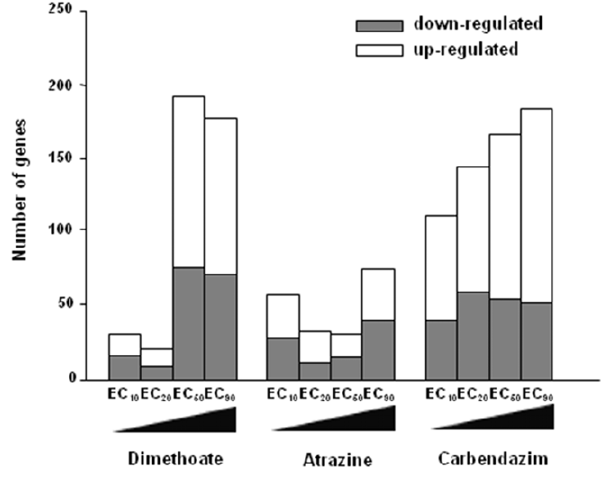
Figure 1. Number of differentially expressed genes after dimethoate, atrazine and carbendazim exposures. Number of significant up- and down-regulated genes (two sample t -tests, p , 0.05) in Enchytraeus albidus after exposure to dimethoate, atrazine and carbendazim in four different concentrations (reproduction EC 10 , EC 20 , EC 50 and EC 90 ). Values refer to the comparison with the respective